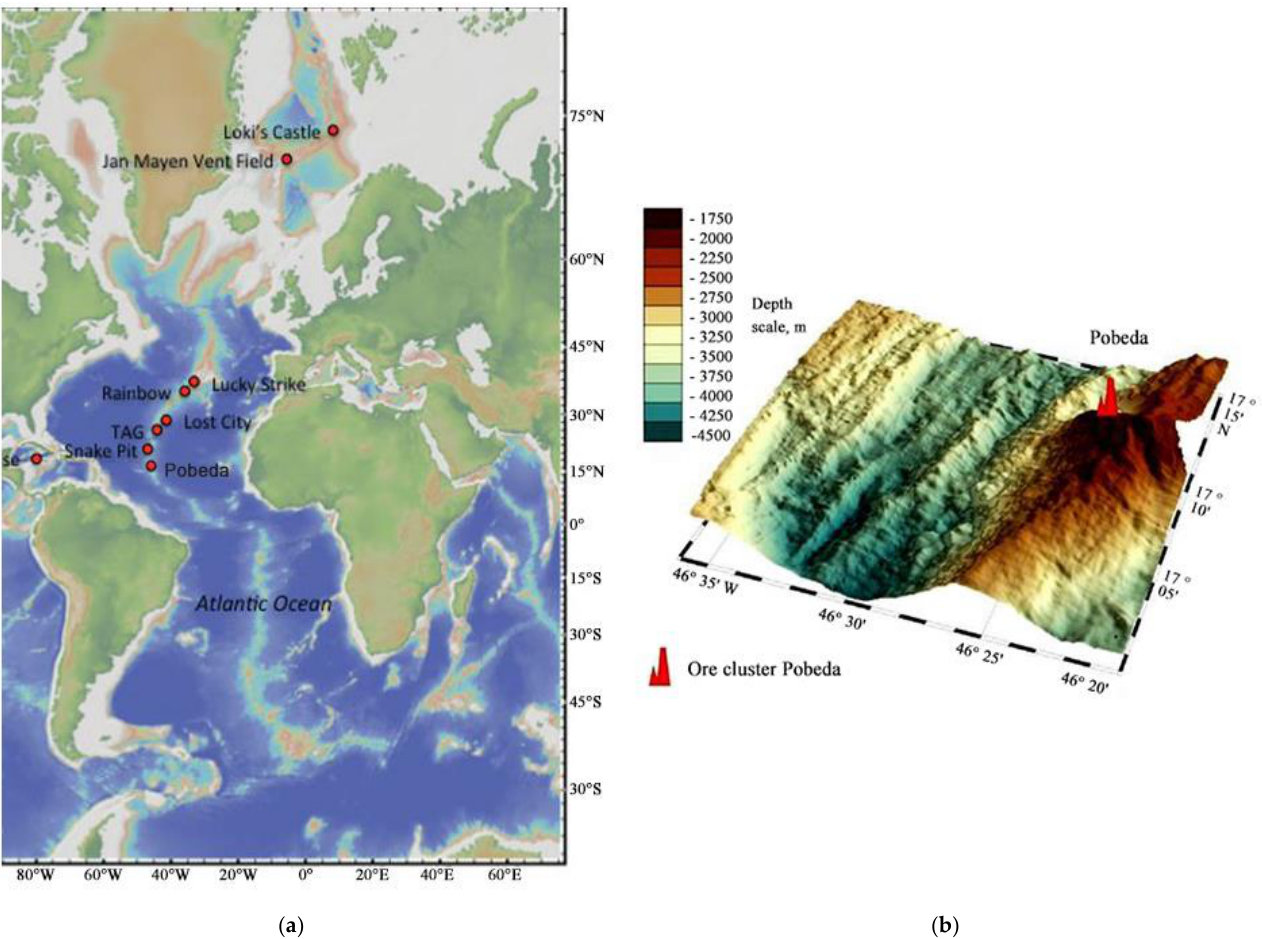
Figure 1. The Pobeda ore cluster’s location among the known hydrothermal fields at the Mid-Atlantic Ridge ( a ) and scheme of the rift valley ( b ) (https://motherboard-images.vice.com/content-images/contentimage/14339/1407427503312474.jpg, accessed on 31 May 2021).